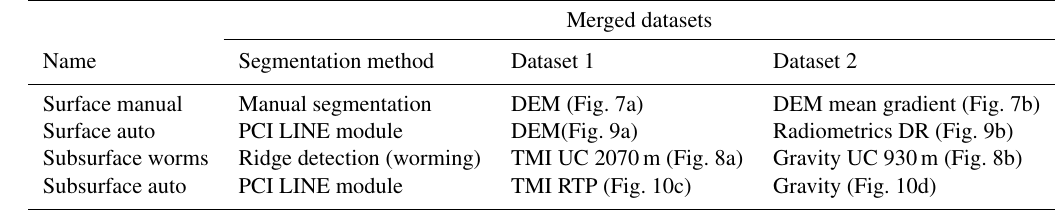
Table 1. Merged datasets corresponding to surface and subsurface signals obtained with the same method.